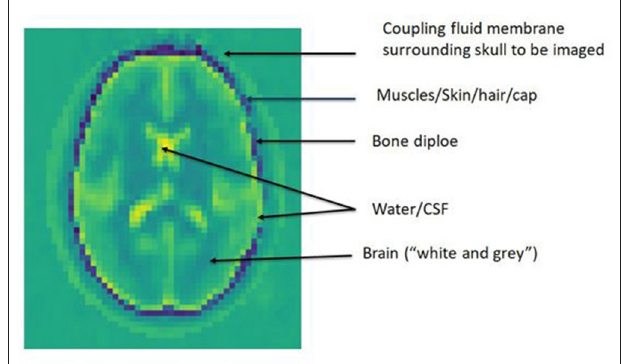
FIGURE 2 | Permittivity map showing anatomical